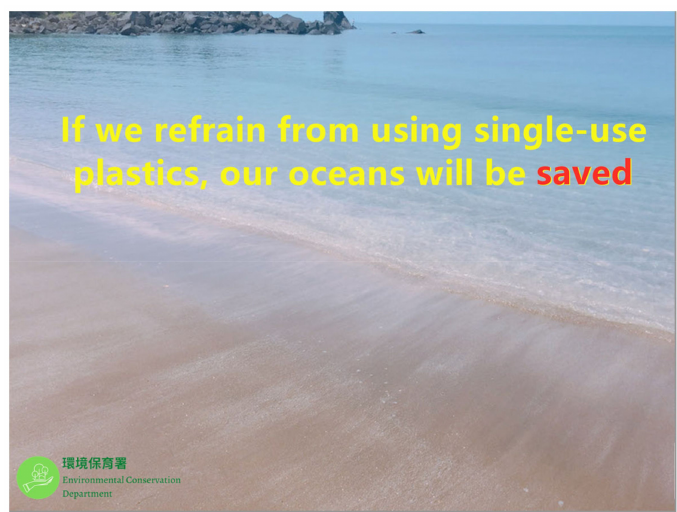
Figure A5. Example of condition 5: Gain * image * government.